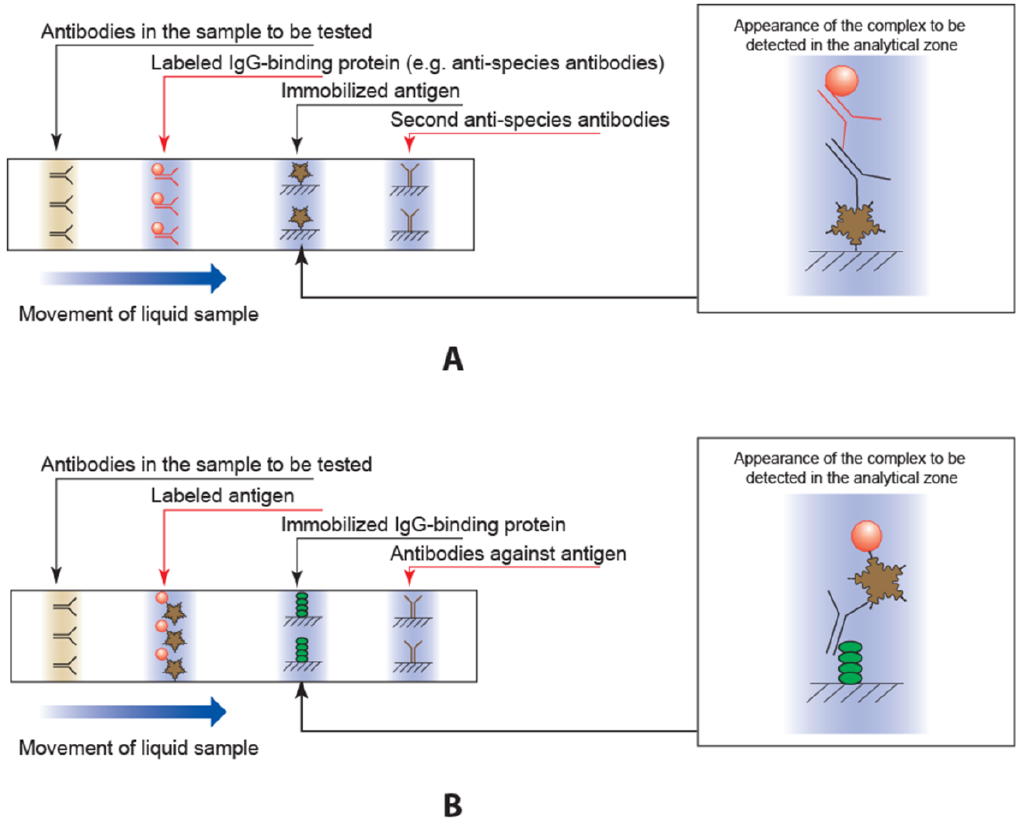
Figure 1. Traditional scheme A ( A ) and alternate scheme B ( B ) of immunochromatographic serodiagnosis.